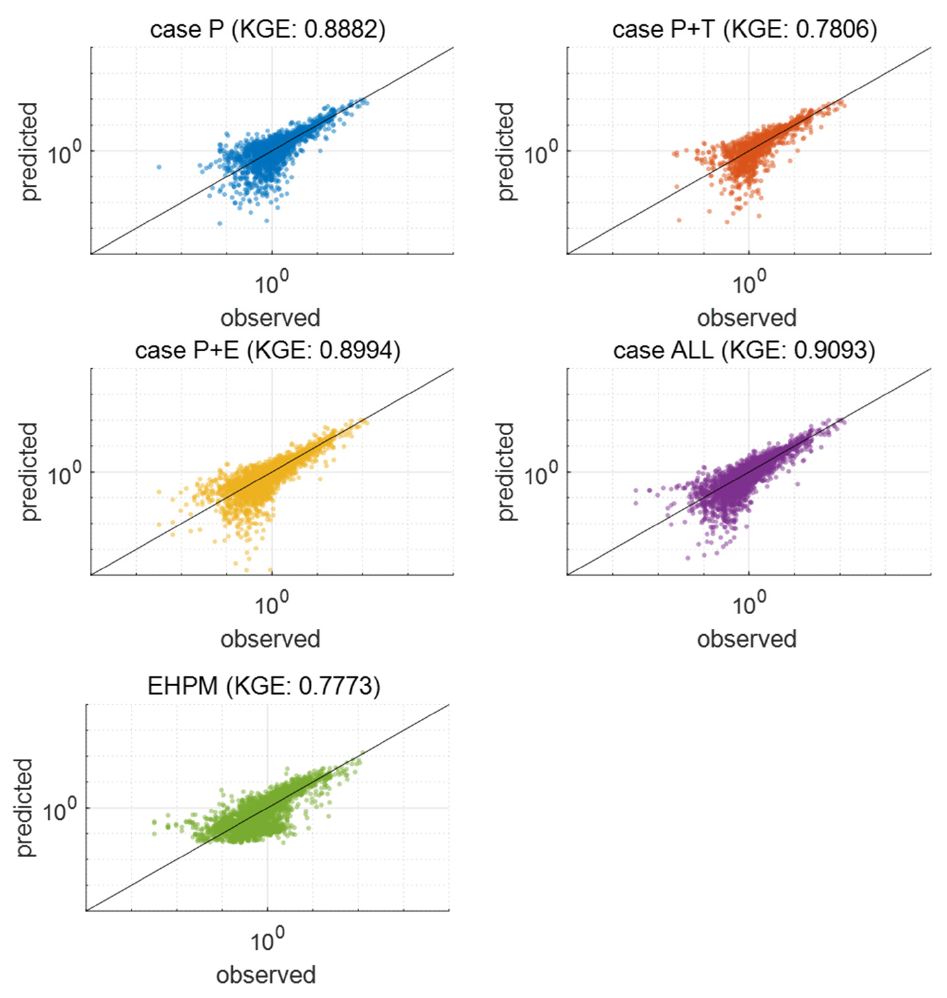
Figure 4. Scatterplots of observed and predicted streamflow during the test period, where P is the case where only rainfall is input, P+T is where rainfall and temperature are input, P+E is where rainfall and potential evapotranspiration are input, ALL is where all meteorological information is input, and EHPM is the benchmark model.